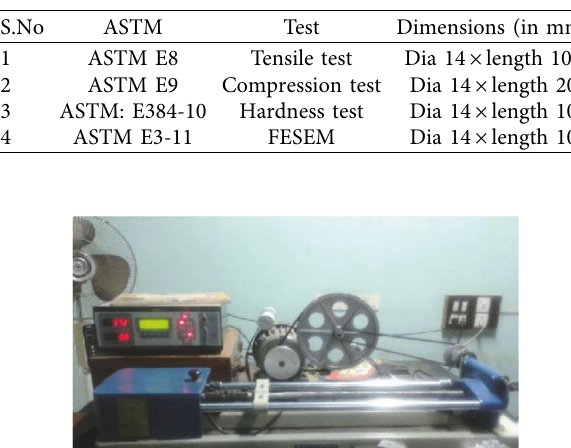
Figure 2: Experimental setup of the stir casting process. Table 3: ASTM for tensile, compression, hardness, and FESEM.